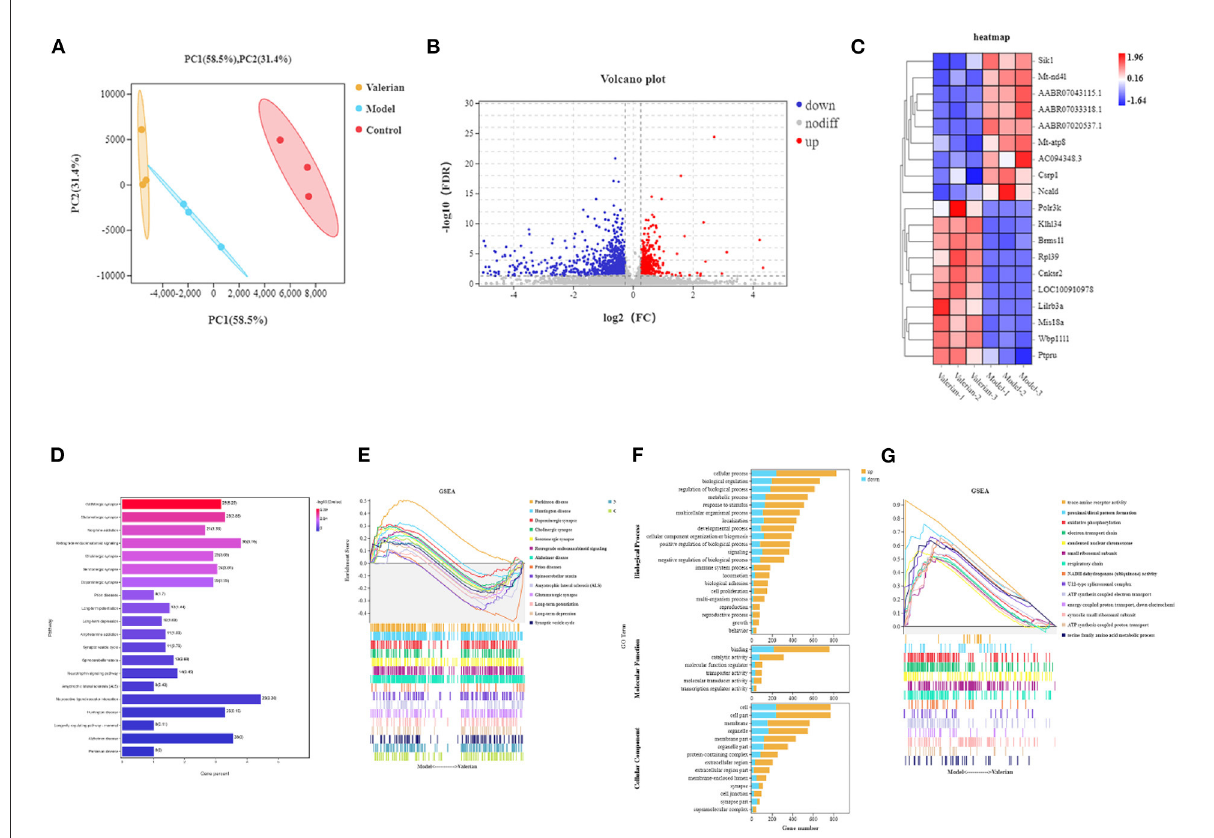
FIGURE2 (A) PCA cluster analysis diagram. (B) Differential gene volcano map. (C) Differential gene heat map. (D) Enrichment analysis results of sequencing differential gene KEGG. (E) GSEA pathway enrichment analysis results. (F) Sequencing difference gene go enrichment results. (G) GSEA go enrichment analysis